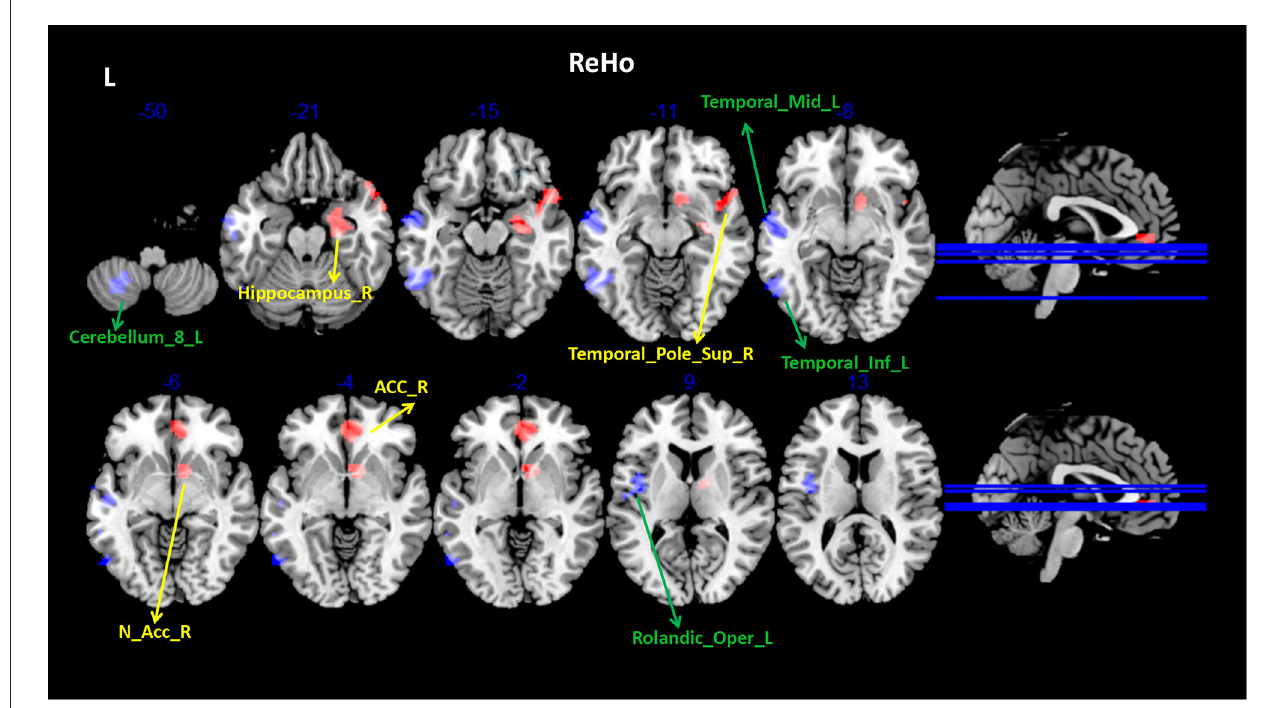
FIGURE1 Group differences in ReHo between patients with PDM and HCs (voxel threshold: uncorr. P < 0.001, cluster threshold: p -FWE < 0.05). Patients with PDM had significantly higher ReHo values (yellow arrow) in the right hippocampus, temporal pole superior temporal gyrus, nucleus accumbens, and pregenual anterior cingulate cortex; and lower ReHo values (green arrow) in the left Cerebellum_8, middle temporal gyrus, inferior temporal gyrus, rolandic operculum. ReHo, regional homogeneity; PDM, patients with primary dysmenorrhea; HCs, healthy controls; FWE, family-wise error.